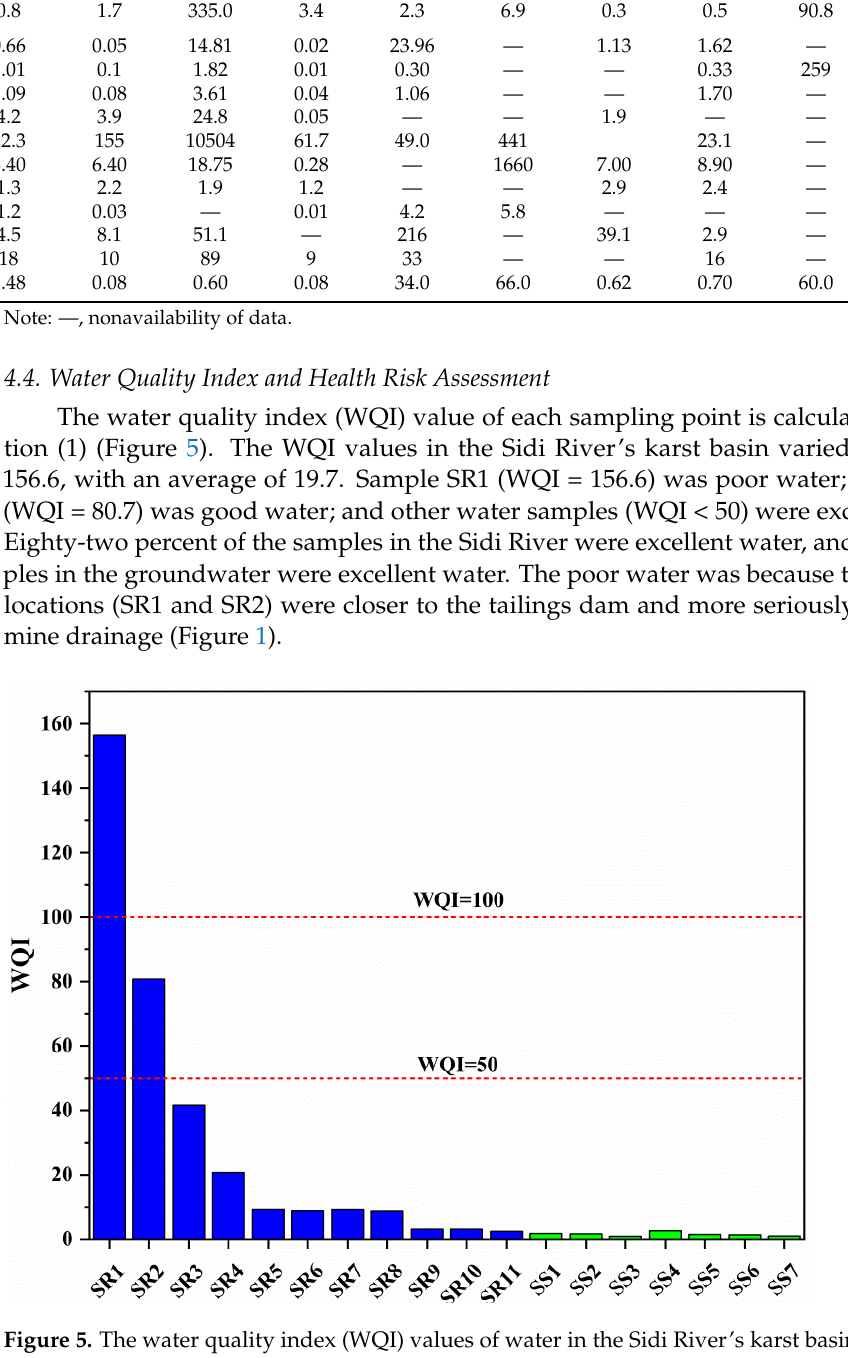
Figure 5. The water quality index (WQI) values of water in the Sidi River’s karst basin. According to PCA, we calculated the weight of each dissolved heavy metal in the water of the study area (Table 5). The calculated method of the HQ and HI was shown in Equations (2)–(6). The HQ ingestion , HQ dermal , and HI values were much less than 1 (Table 6), indicating that these elements were less harmful. Compared with dermal, ingestion was the main route, by which these dissolved heavy metals harmed humans. Children’s HQ ingestion , HQ dermal , and HI values were higher than adults, indicating that children were